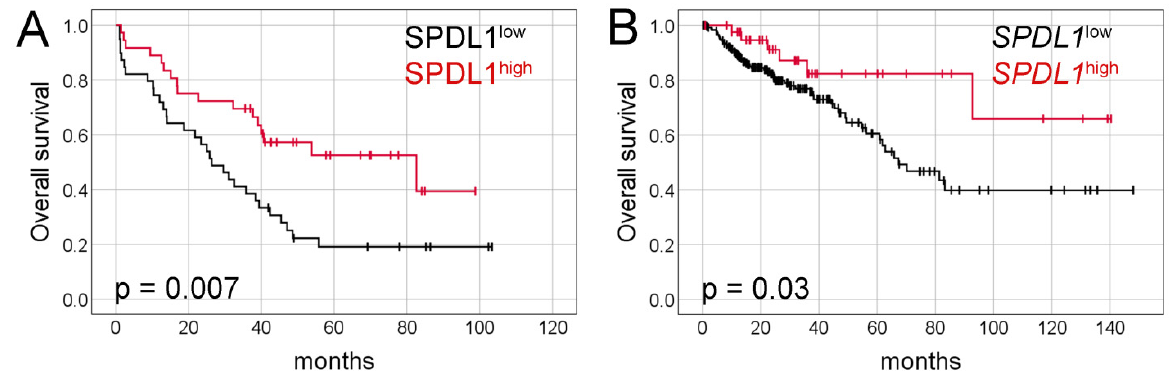
Figure 2. Kaplan ‐ Meier survival curves and log ‐ rank test for overall survival of CRC patients based Figure 2. Kaplan-Meier survival curves and log-rank test for overall survival of CRC patients based on ( A ) SPDL1 protein expression and ( B ) SPDL1 mRNA expression. on ( A ) SPDL1 protein expression and ( B ) SPDL1 mRNA